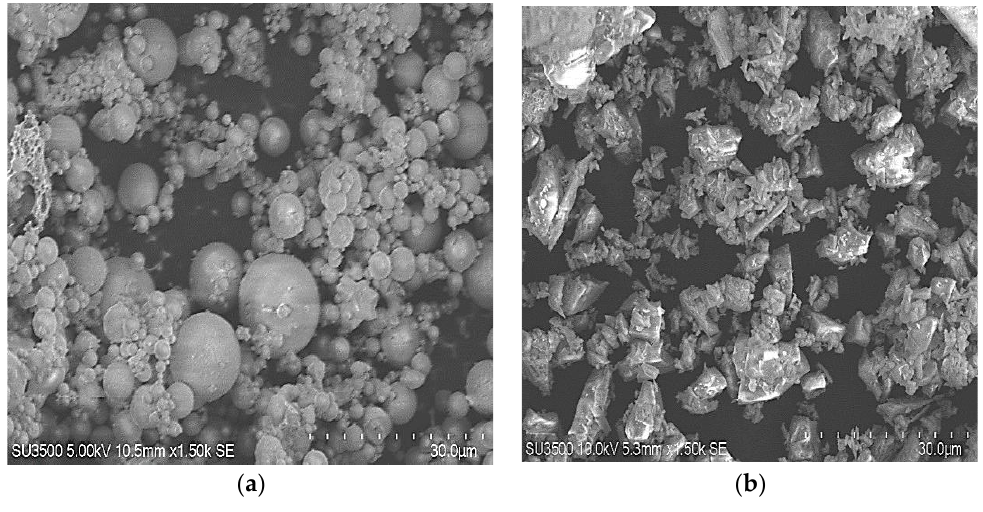
Figure 2. SEM results: ( a ) class-F fly ash (FA); ( b ) S-4000 GGBS. Table 2. Composition of class-F fly ash (FA) and S-4000 GGBFS as determined by XRD (mass %).